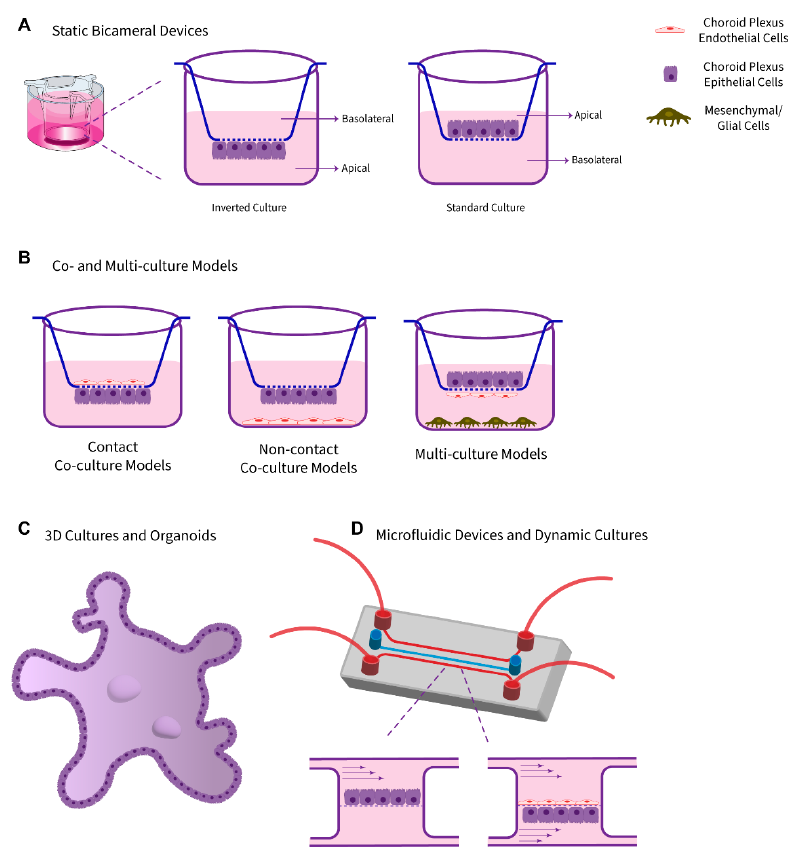
Figure 2. Various possible in vitro BCSFB model platforms are schematically depicted here. ( A ) Static bicameral devices or alternatively known as cell culture filter inserts monolayers. This compartmentalized model, as the mostly utilized configuration by a preponderance of studies, represents culture of choroid plexus epithelial cells either in standard or inverted format on a suitable permeable filter insert; ( B ) Co-culture and multi-culture filter inserts. Here, choroid plexus epithelial cells are grown on porous cell culture inserts alongside endothelial, mesenchymal (e.g., pericytes), and/or glial cells either cultivated into the bottom of a multi-well plate in which the insert is located (non-contact) or seeded on the opposite side of the inserts containing epithelial cells (leading to a so-called back-to-back contact co-culture); ( C ) Three-dimensional cultures and organoids; ( D ) Dynamic cultures or microfluidic devices. The upper and lower channels of the devices are separated to model the luminal and abluminal membrane interfaces based on cell culture direction and a tunable shear stress is induced by a continuous flow of culture medium.